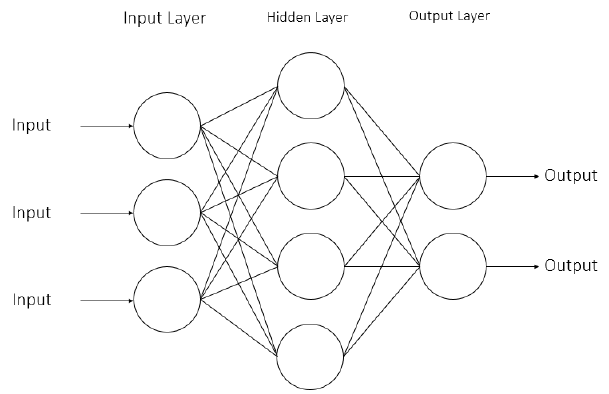
Figure 5. Artificial Neuronal Network